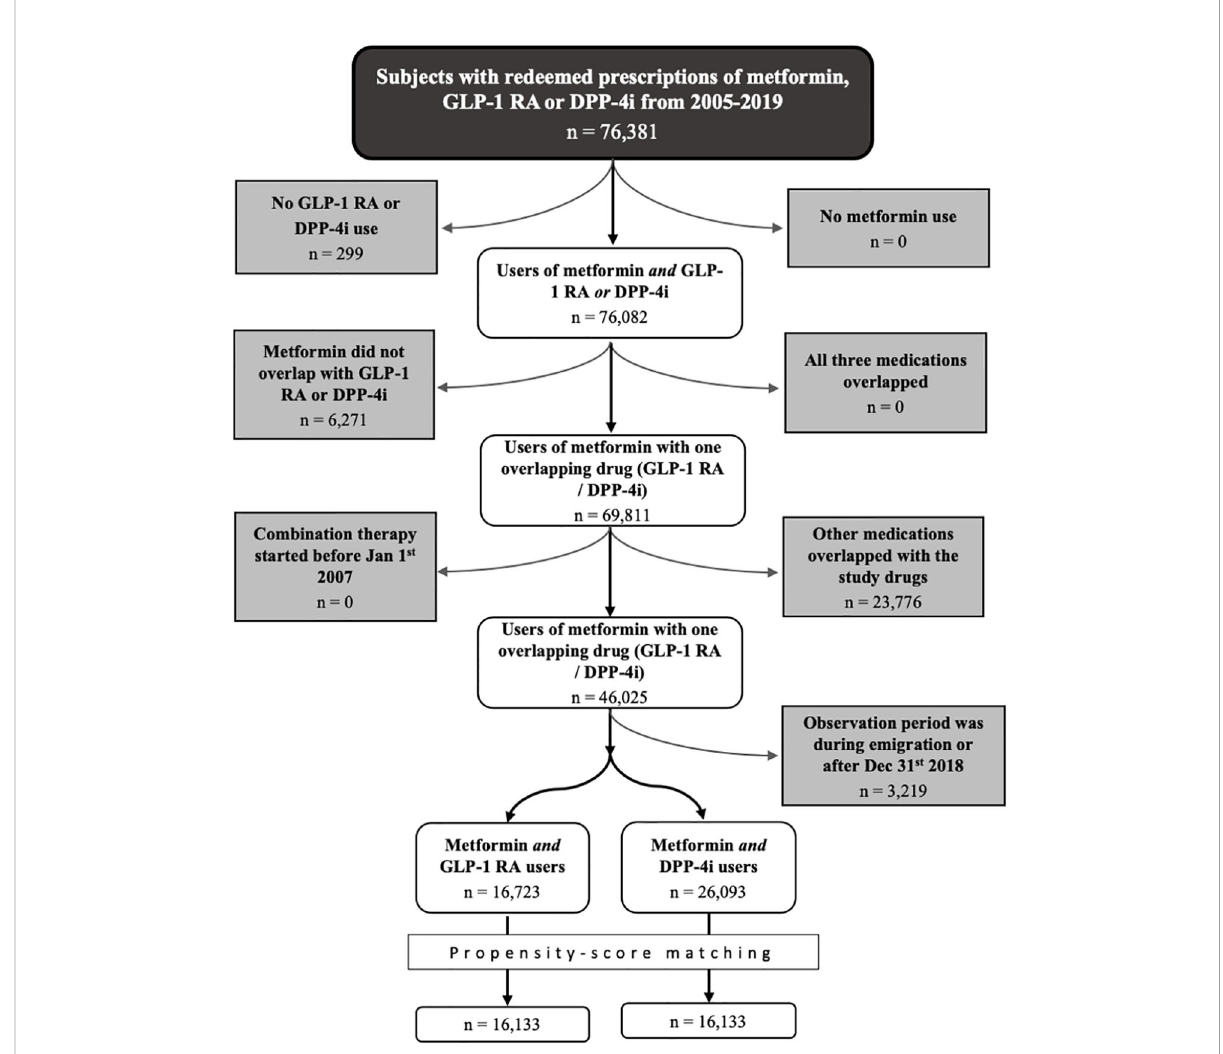
FIGURE 1 Flowchart of the process of in-/exclusion. DPP-4i, dipeptidyl peptidase 4 inhibitor; GLP-1 RA, glucagon-like peptide-1 receptor